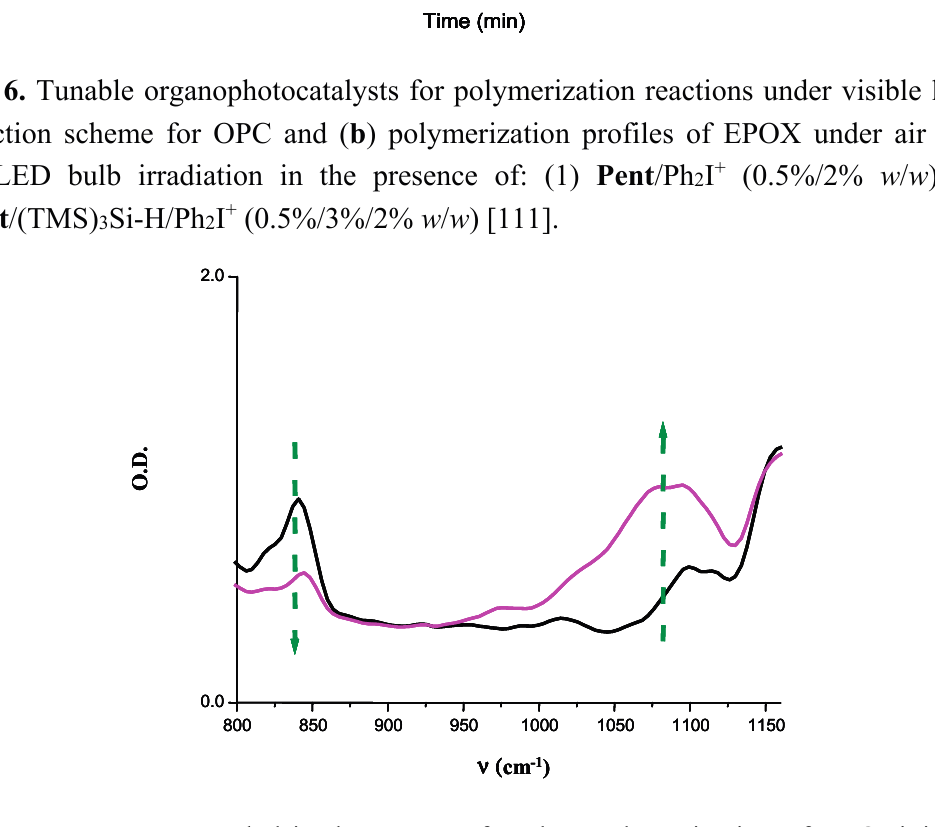
Figure 7. IR spectra recorded in the course of a photopolymerization of ELO; initiating system: BPSK/Ph 2 I + /TTMSS (1%/2%/3% w/w) upon a fluorescent bulb irradiation (from t = 0 to 30 min); under air